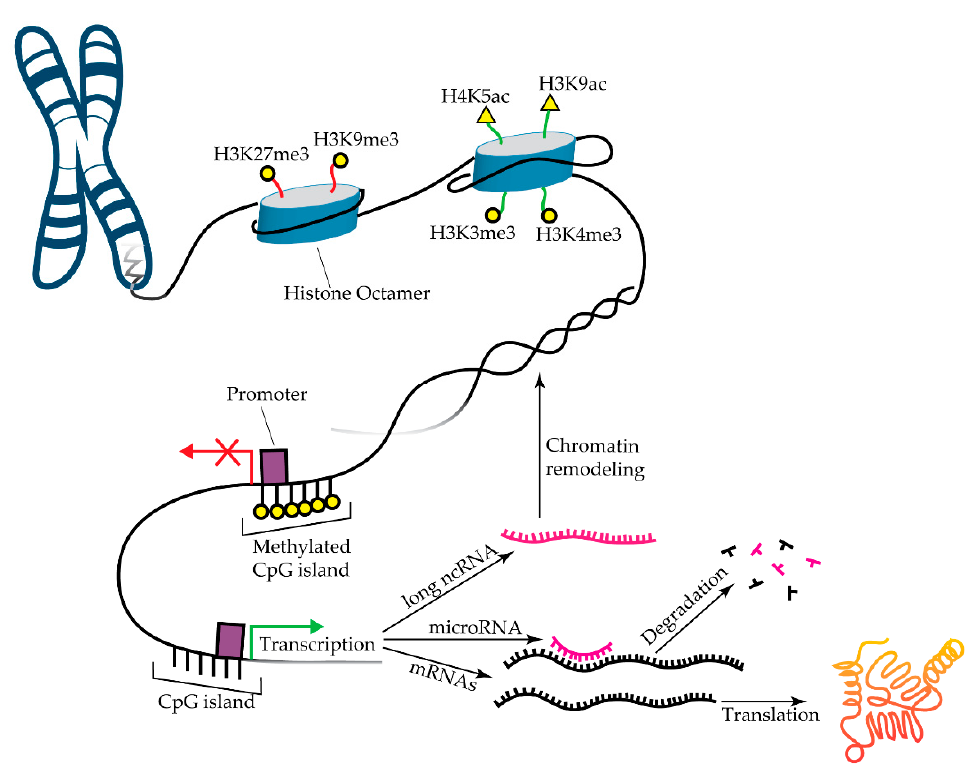
Figure 2. Mechanisms of Epigenetic Modification. Representative histone marks are depicted, but there are several other sites of histone methylation and acetylation. By altering chromatin structure, H3K27me3 and H3K9me3 inhibit transcription, while H4K5ac, H3K9ac, H3K3me3, and H3K4me3 promote transcription. Figure inspired by [67,68]. Reproduced with permission from D’Addario, et